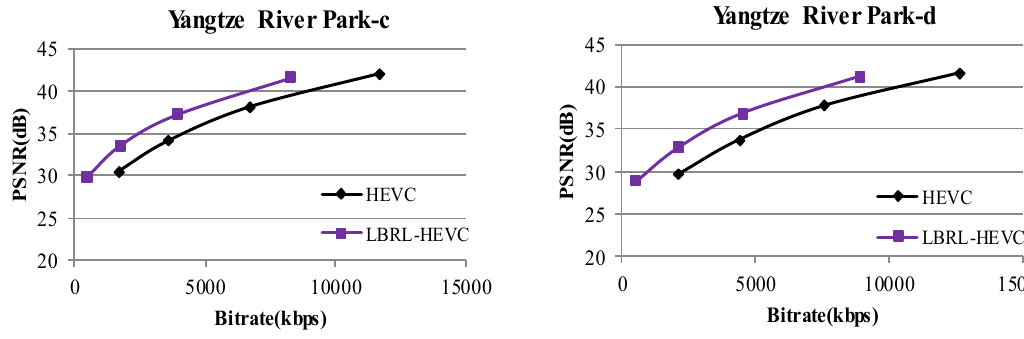
Figure 7. RD curves of LBRL-HEVC and HEVC for four video clips from UAV data.